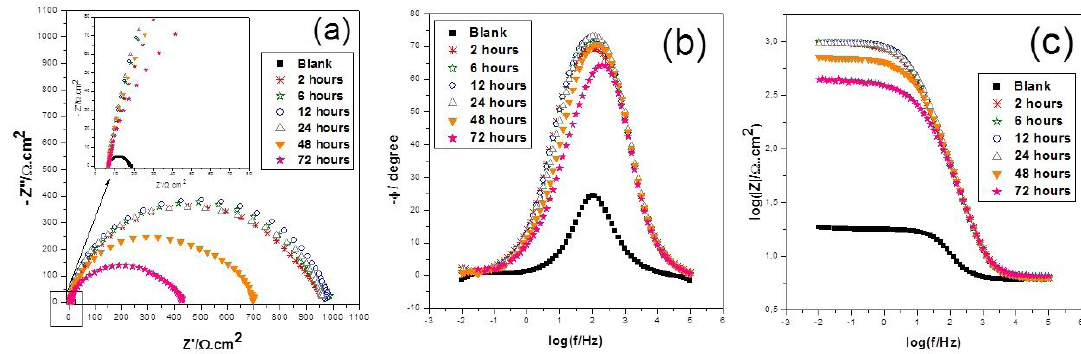
Figure 12. Nyquist (a) and Bode plots, containing the phase angle (b) and logarithm of the impedance modulus (c), for the carbon steel in the presence of 1.77 g L -1 of the cocoa bean shell powder at different immersion